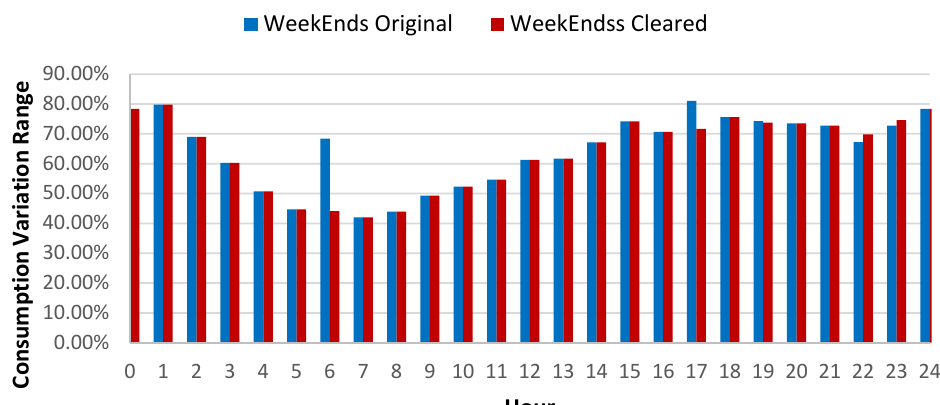
Figure 19. Energy consumption variation range compared to hourly average weekend consumption for original and cleared data sets.